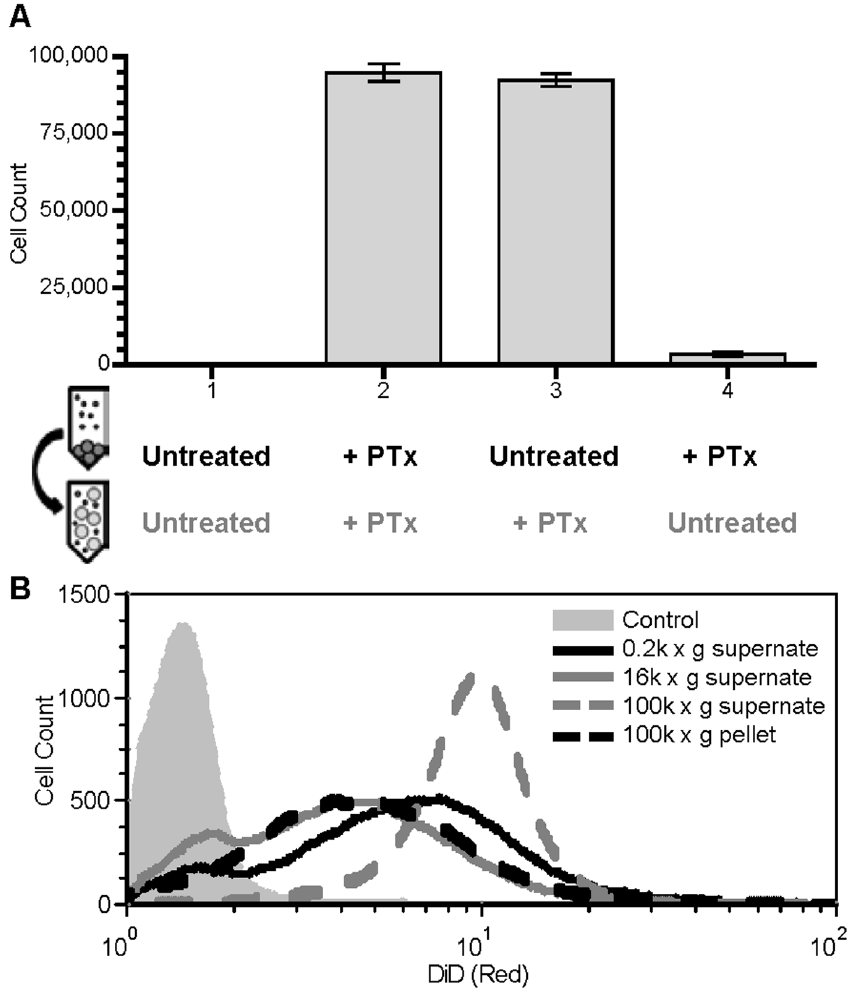
Figure 5. Cell-to-cell contact is not required for membrane transfer. A. Effect on transfer of cell depleted supernatant, from PTxM-treated or untreated Green 2 / Red + Jurkat cells, added to a population of PTxM treated or untreated Green + /Red 2 Jurkat cells with schematic representations of protocols below related data. Results represent the mean transfer population size of three independent assays with standard deviation. B. Effect on transfer of differentially centrifuged cell depleted supernatant from untreated Green 2 /Red + Jurkat cells, added to a population of PTxM treated Green + /Red- Jurkat cells. Untreated Green + /Red- Jurkat cells with 200 6 g supernatant (grey field) and PTxM treated Green + /Red- Jurkat cells with 200 6 g supernatant (black solid line), 16,000 6 g supernatant (dark grey solid line), 100,000 6 g supernatant (dark grey dashed line), or the resuspended pellet from the100,000 6 g supernatant (black dashed line). doi:10.1371/journal.pone.0072885.g005 (Fig. 9B), with similar dose-response characteristics. The ability of examined (Fig. 9C). For both Jurkat and CHO cells, WGA plant lectins to promote membrane transfer in CHO cells was also mediated efficient membrane transfer, while sucWGA, ConA and Table 1. Activity of PTx and Lectins on Aggregation and Membrane Transfer in Jurkat cells.